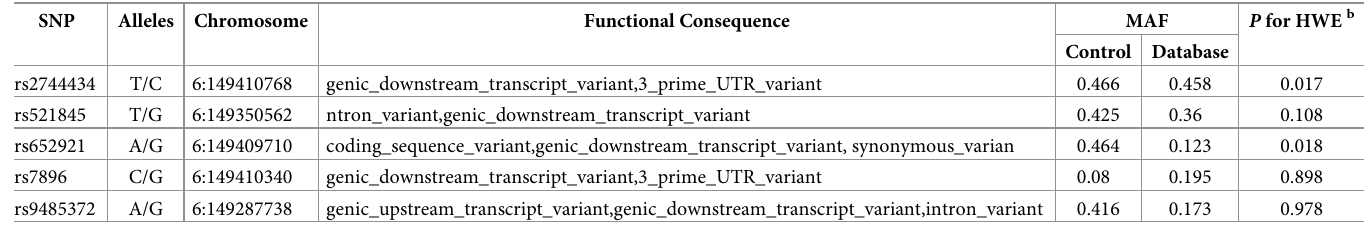
Table 2. General information of selected SNPs and Hardy-Weinberg